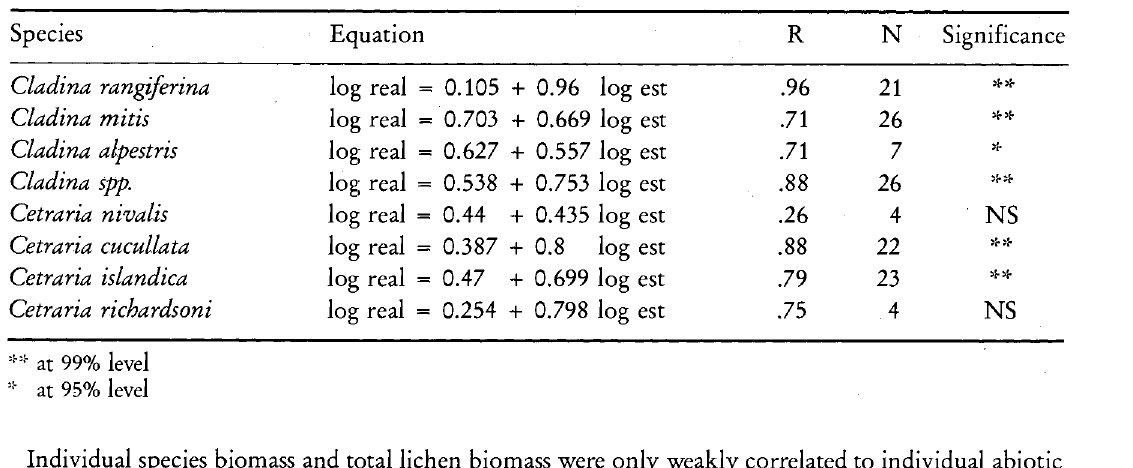
Table 2.6. Regression of log real versus log estimated biomass by species.